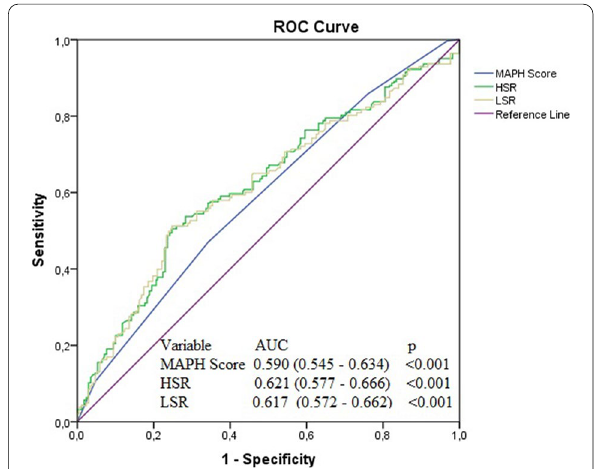
Fig. 2 Receiver operating characteristics curve analysis of MAPH score, LSR and HSR in predicting high thrombus